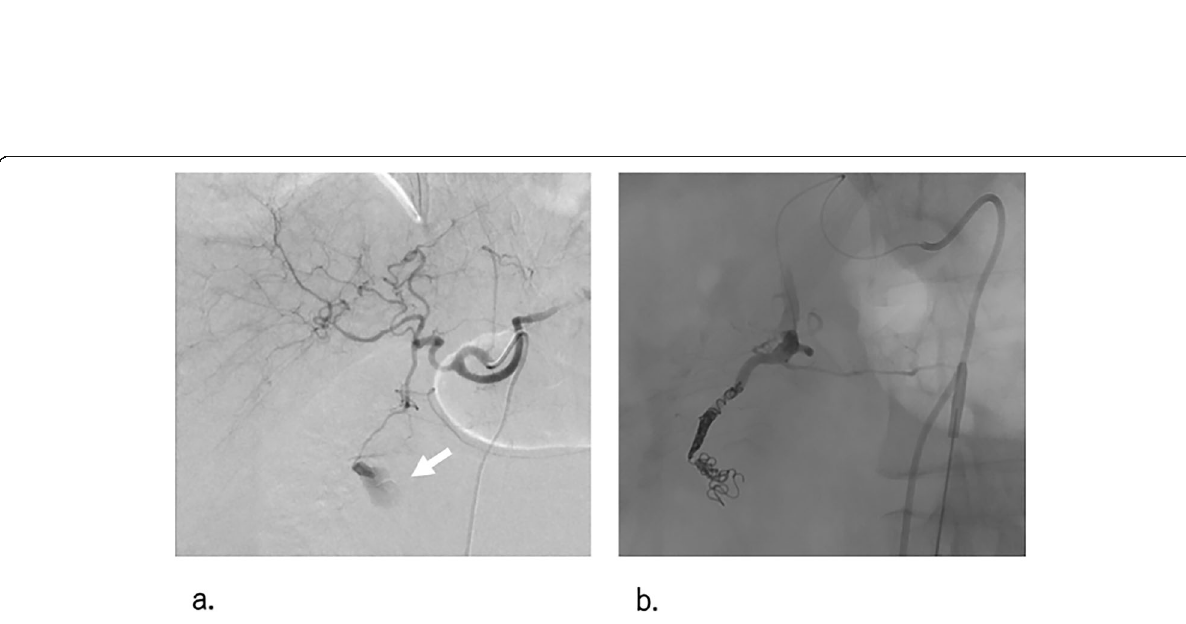
Fig. 2 Celiac artery angiography at emergency transarterial embolization (TAE). a Celiac artery angiogram showing extravasation (white arrow) from the ASPDA, and its disruption. In addition, no median ligament compression syndrome was noted. b Digital angiogram, obtained after TAE of the ASPDA, showing a pseudoaneurysm, and the disappearance of extravasation from the celiac artery system. The ASPDA appears to be dilated, because a severe vascular spasm due to haemorrhage was relieved after TAE. ※ ASPDA: anterior superior pancreaticoduodenal artery